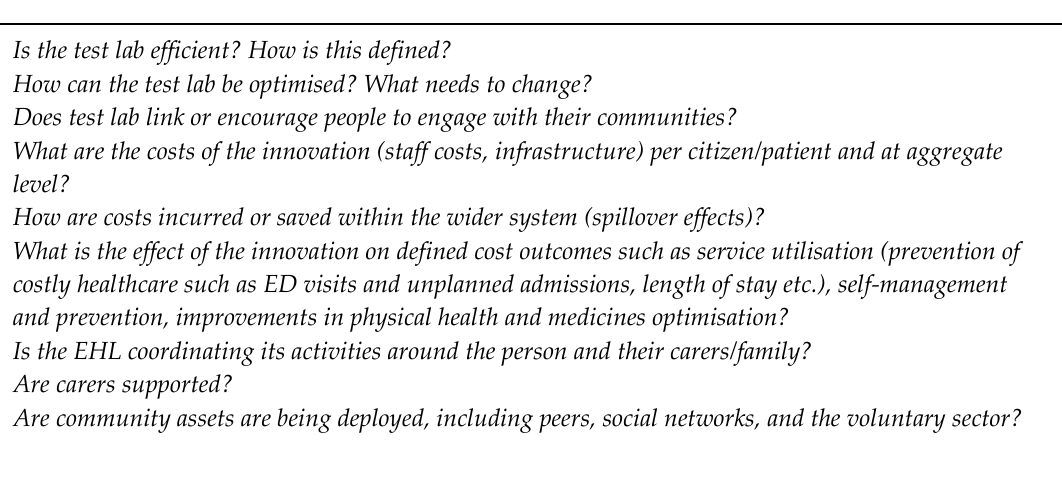
Figure 4. Questions for cost in the “health